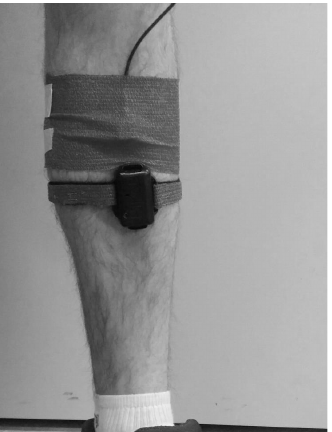
Figure 3. Attachment method of the IMU and the reference sensor on the subject’s